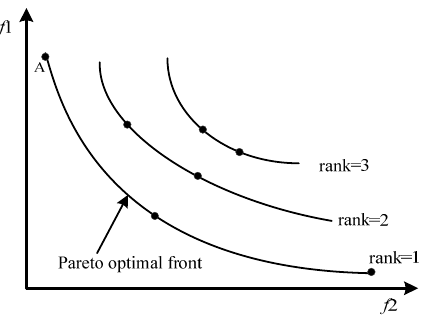
Figure 5. The layering schematic of population.